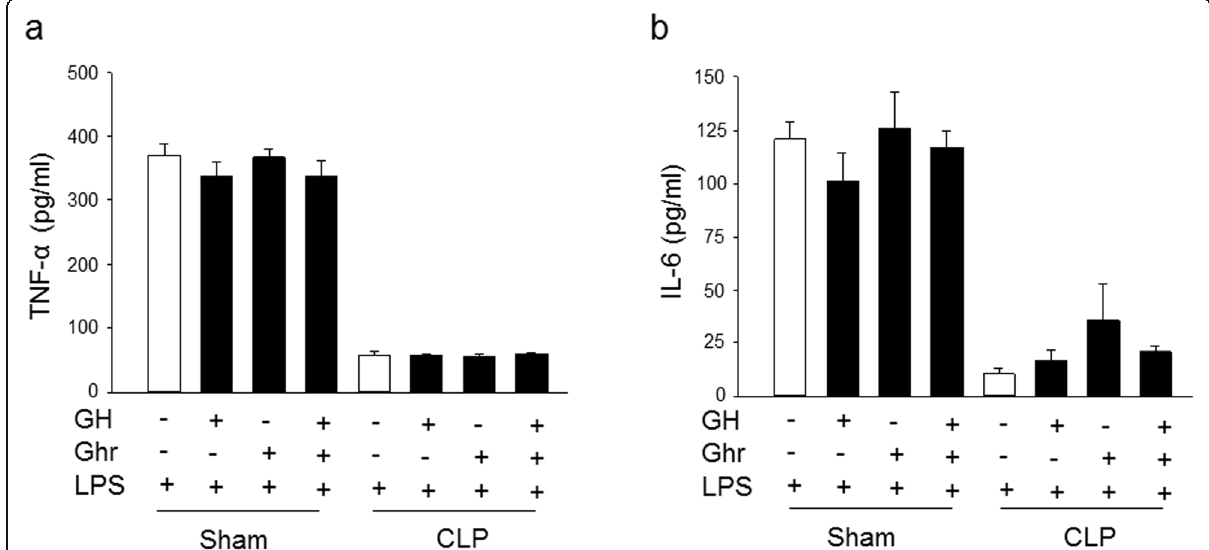
Fig. 6 In vitro treatment of ghrelin and GH have no effect on the immune response of splenocytes of aged septic rats. Rats were subjected to sham or CLP operation. Spleens were harvested at 20 h after CLP. Splenocytes were isolated and treated with ghrelin (Ghr), GH or GG in vitro, followed by the stimulation with LPS (100 ng/ml) for 5 h. The release of ( a ) TNF- α and ( b ) IL-6 in the medium were measured by ELISA. Data are expressed as mean ± SEM ( n = 3 rats/group)